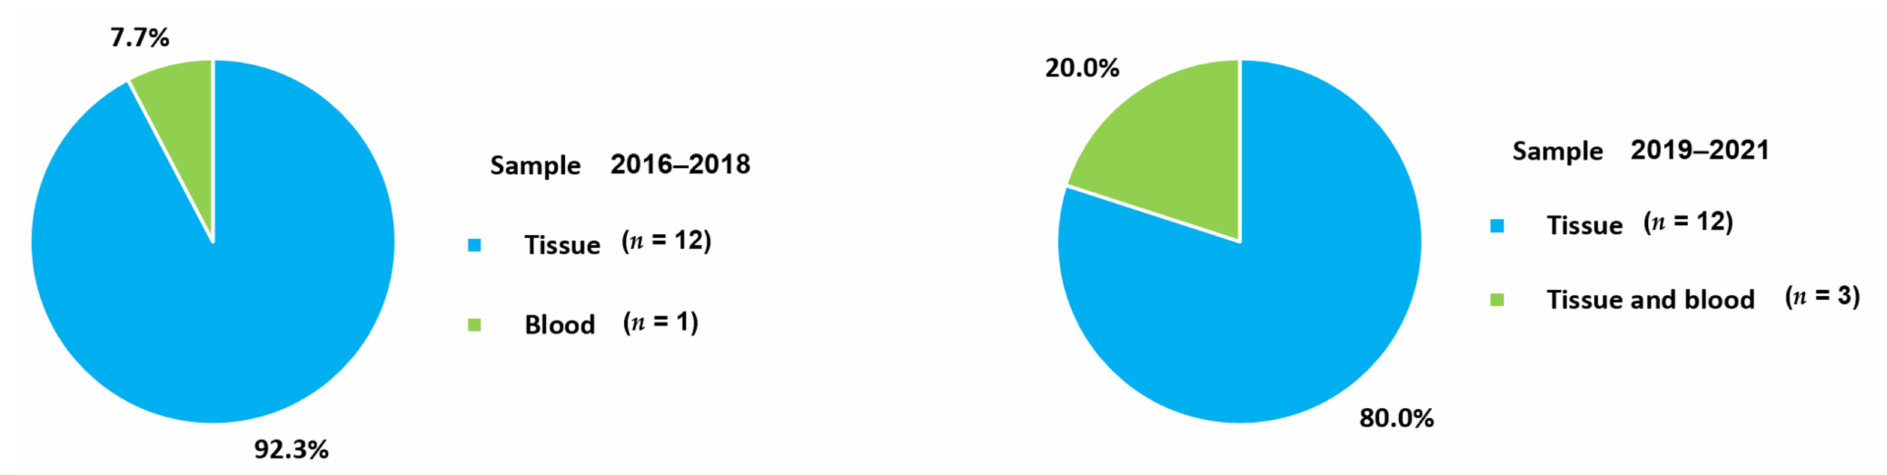
Figure 6. Changes in the used sample types according to the